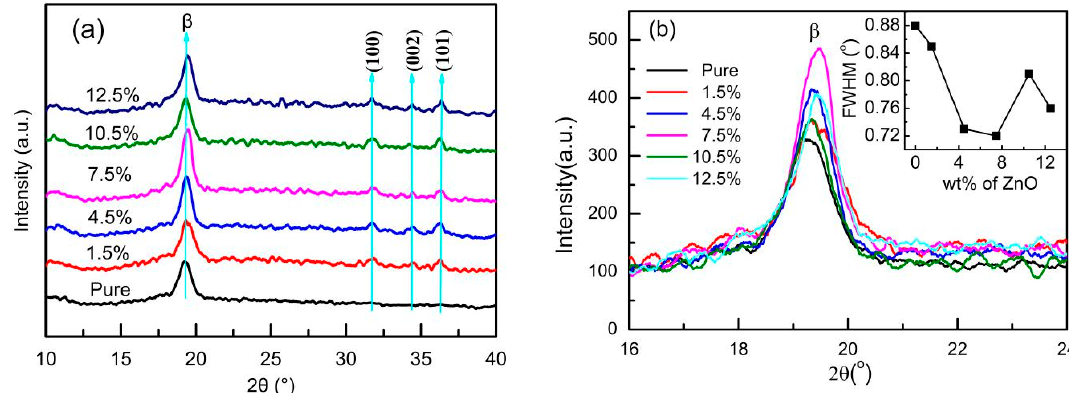
Figure 6. WXRD spectra of different nano-ZnO doped PVDF-TrFE/nano-ZnO films: ( a ) XRD patterns; and ( b ) peak intensity of β -phase and FWHM of β -phase with different ZnO Contents.